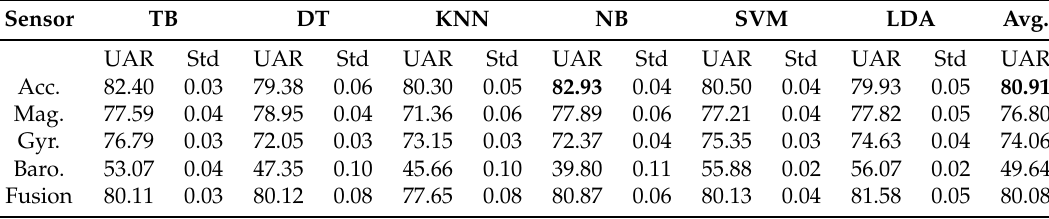
Sensor Acc. Mag. Baro. Fusion Table 7. Super-bagging results for non-dominant hand: Unweighted Average Recall (UAR) in % along with the standard deviation (Std) of UAR for each fold (i.e., subject) of classification. The bold figures indicate the best results. Sensor Acc.